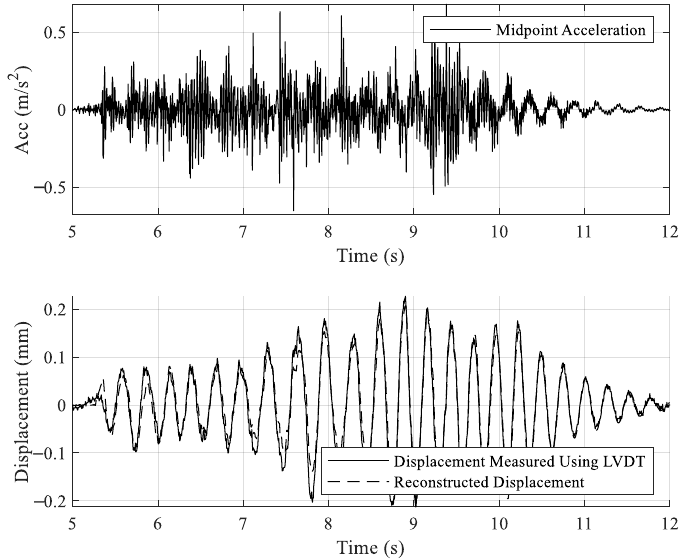
Figure 15. LVDT displacements and reconstructed displacements (bottom) from accelerations (top) on scenario LVB0S3.